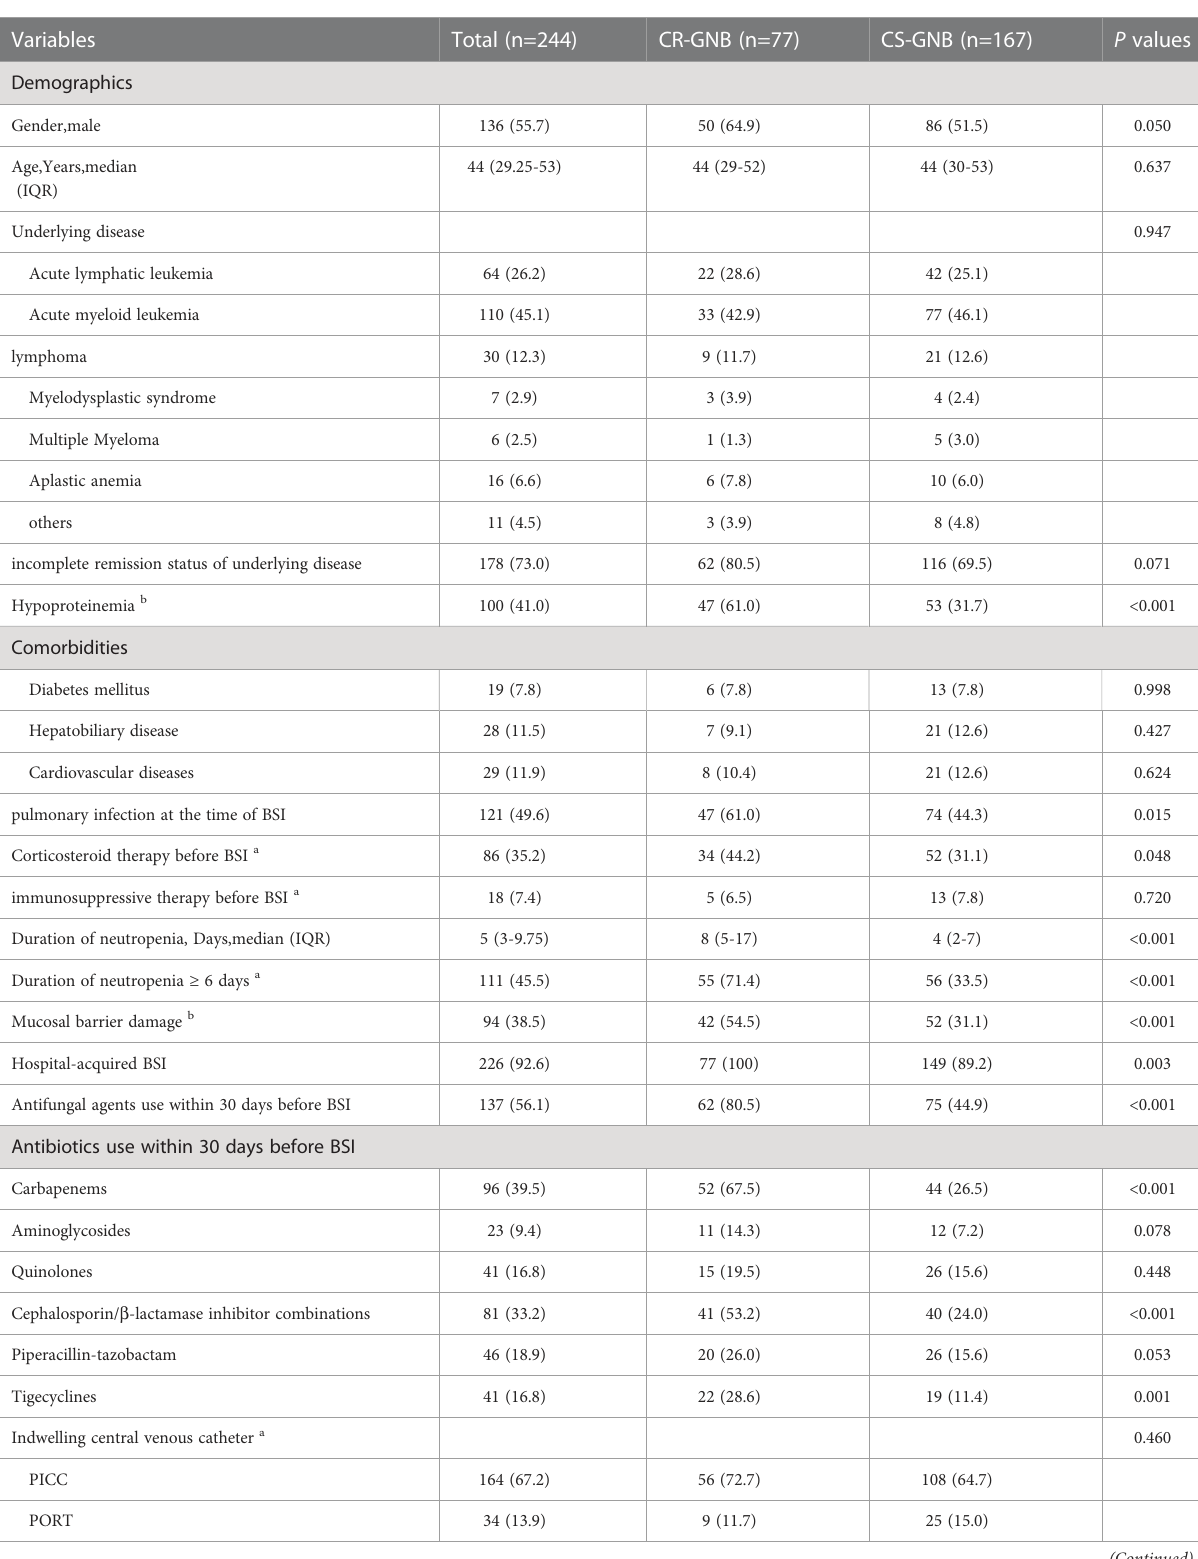
TABLE 2 Clinica and demographic characteristics of hematological patients with bloodstream infection caused by gram-negative bacteria based on the carbapenem resistance of strains.